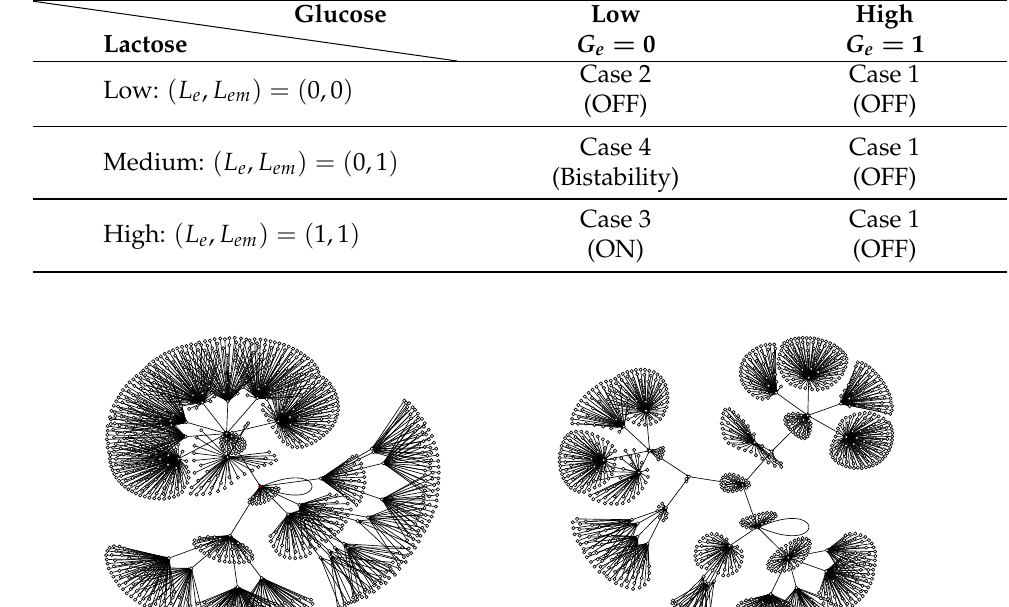
Table 1. The possible cases in the original model for each of the six combinations of parameters.